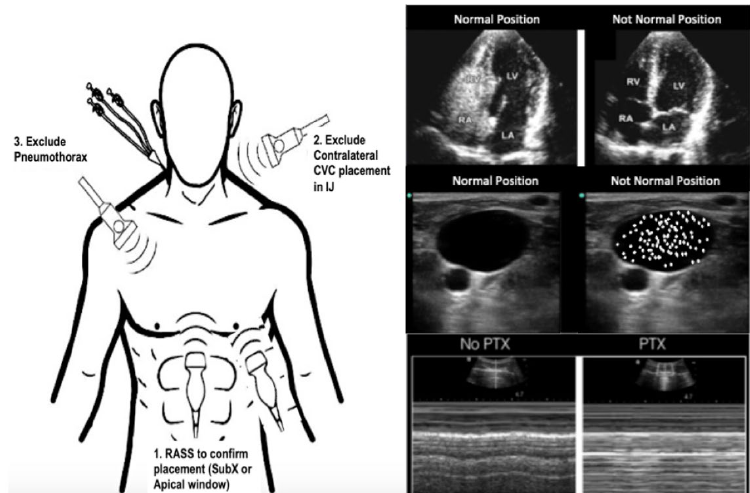
Figure 1. Point-of-care ultrasound-guided catheter confirmation protocol. Image modified from Montrief 2021 3 CVC, central venous catheter; IJ, internal jugular; RASS, right atrial swirl sign; SubX, subcostal view; LV, left ventricle; RV, right ventricle; RA, right atrium; LA, left atrium; PTX,